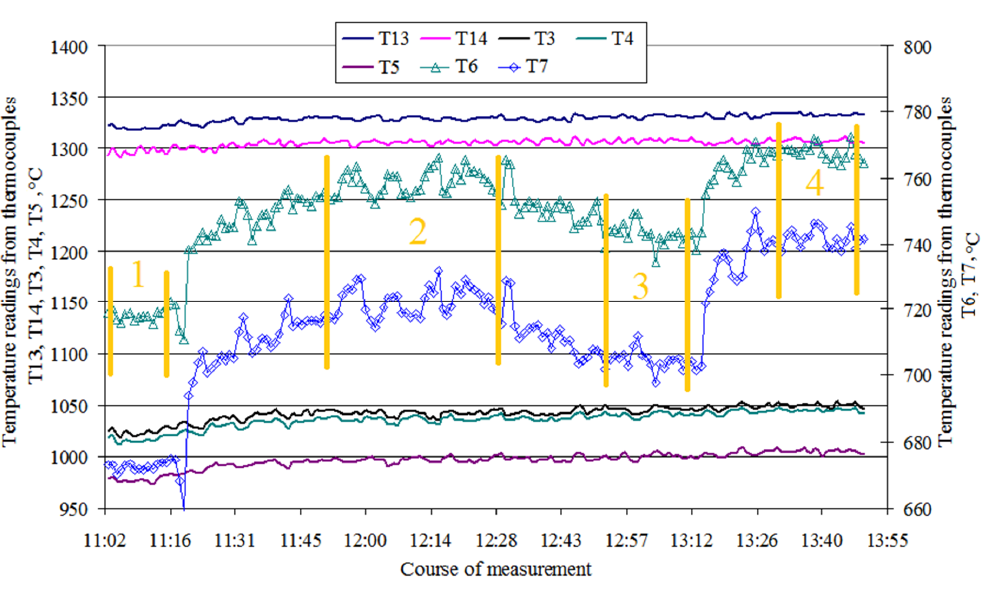
Figure A1. Measured flue-gas temperatures through the furnace during test experiments involving fuel input Q = 1.6 m 3 /h 1 and air excess coefficient m = 1.1 with varying reburning ratio. Stable operation states as indicated in the Figure: 1 = without any primary method applied; 2 = reburning share of 25%; 3 = reburning share of 20%; 4 = reburning share of 35%.